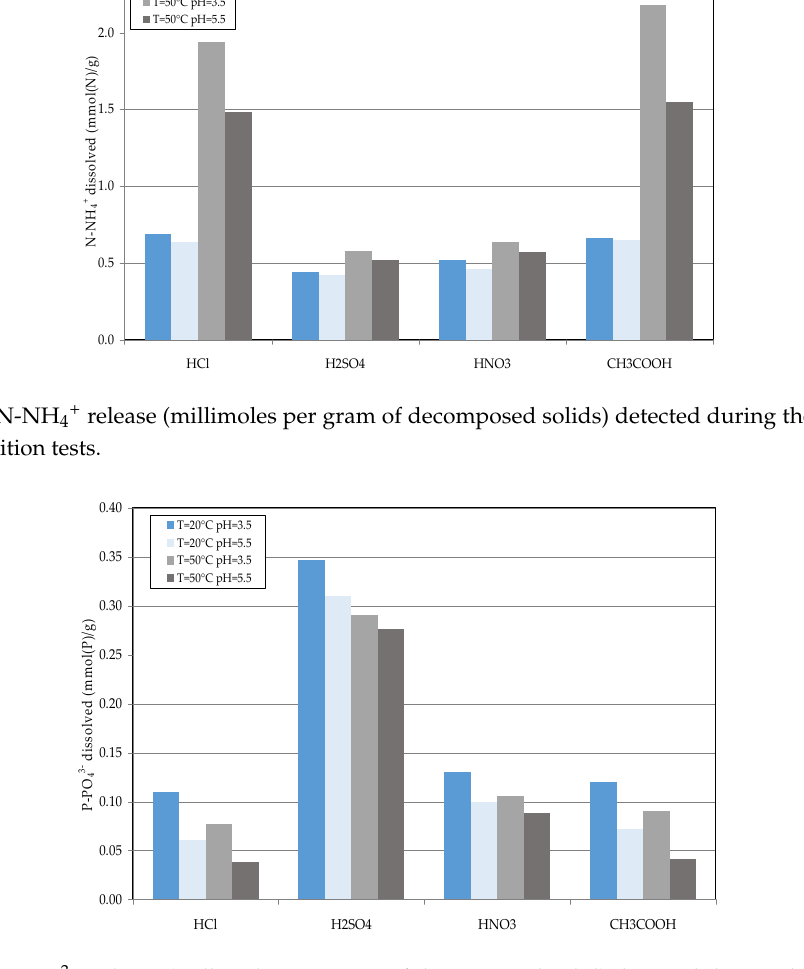
Figure 7. P-PO 4 3 − release (millimoles per gram of decomposed solid) detected during the struvite decomposition